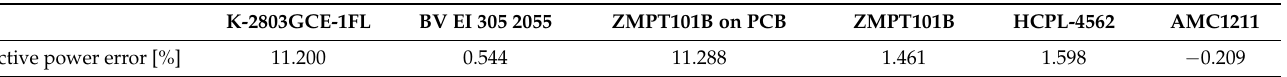
Table 5. The active power error values calculated according to Equation (9) for the normalized input and output waveforms with time-corrected data.